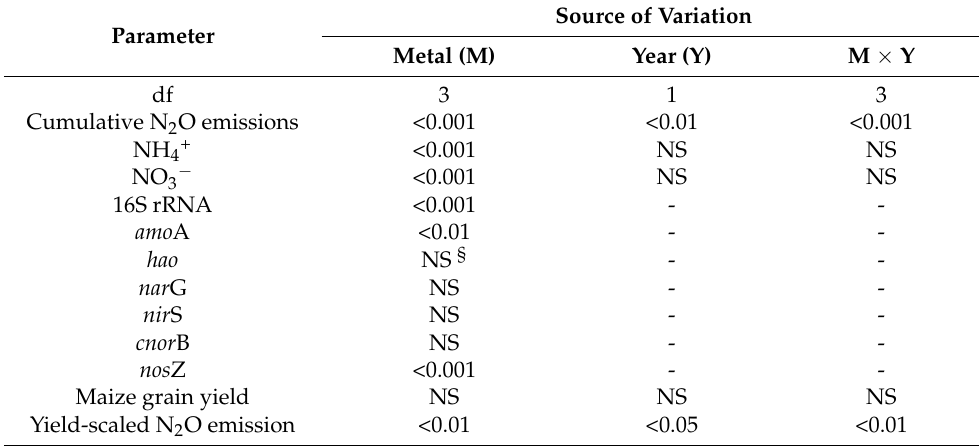
Table 3. ANOVA and p -value of cumulative N 2 O emissions, ammonium (NH 4+ ), and nitrate (NO 3 − ) concentration at harvest, copy numbers of 16S rRNA, amo A, hao , nar G, nir S, cnor B, and nos Z genes, maize grain yield, and yield-scaled N 2 O emissions.